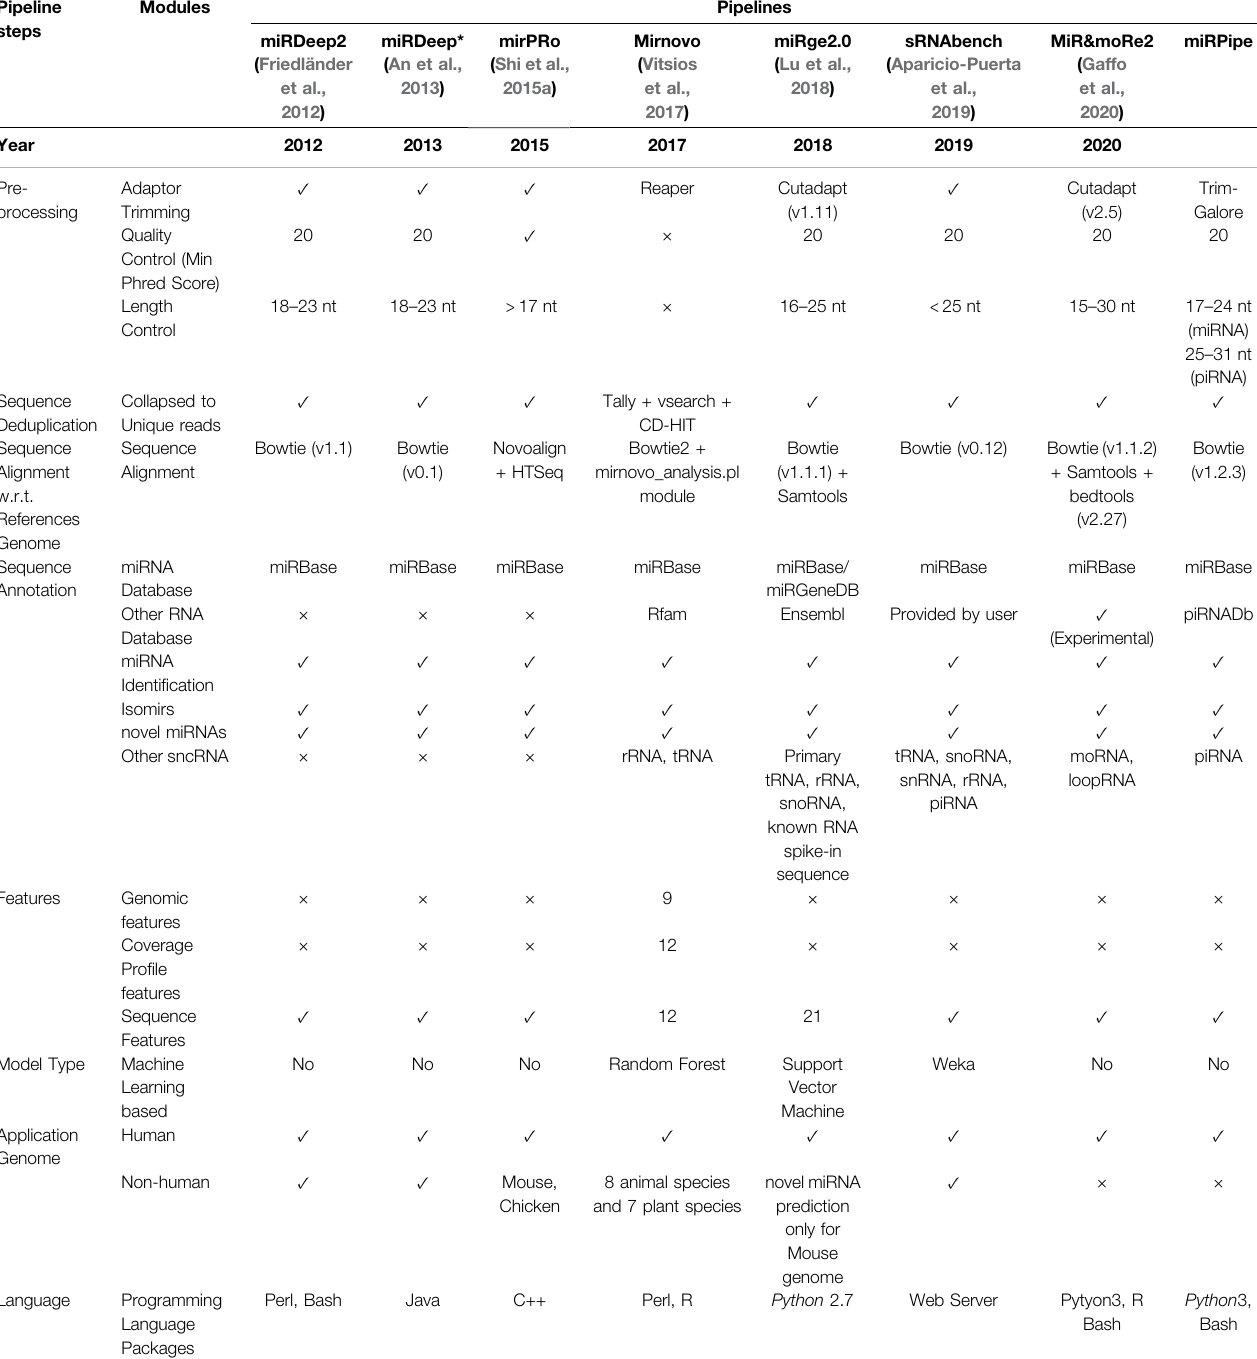
TABLE 1 | Comparison of recently published bioinformatics pipelines on all the intermediate steps such as sequence pre-processing, de-duplication, sequence alignment, andsequenceannotation.Inalltheintermediatesteps,eachpipelineusesdifferenttools(withdifferentversions)ortheirownmodulewritteninlanguagessuchas Python , Perl, R or C++. Further, each pipeline has its own miRNA consideration criteria. For example, miRge2.0 pipeline considers 16 – 25 nt length of sequence for miRNA identi fi cation, while sRNAtoolbox considers all the sequence of length less than 25 nt for miRNA identi fi cation. This difference in length criteria plays a signi fi cant role in the differenceintheaccuracyofmiRNAsequencealignmentstep,whichisthemostcrucialstepinthebioinformaticspipelineformiRNAidenti fi cation.Majorityoftheabove- mentioned pipelines usesBowtie1 forsequence alignment,whilemirnovo pipelineusesBowtie2and mirPRopipeline usesNovoalign sequencealigner.Inourproposed miRPipe, we have used the miRDeep* in Step-3 of the work fl ow with DASHR blast search and seed-based clustering of the novel miRNAs. Most of the pipelines also report other categories ofRNAs present in the sequencing data such as rRNA, moRNA,piRNA, etc. We have also integrated our pipeline piRNA identi fi cation pipeline in miRPipe with parallel thread execution for an optimum use of computational resources to facilitate less overall time to deliver the output